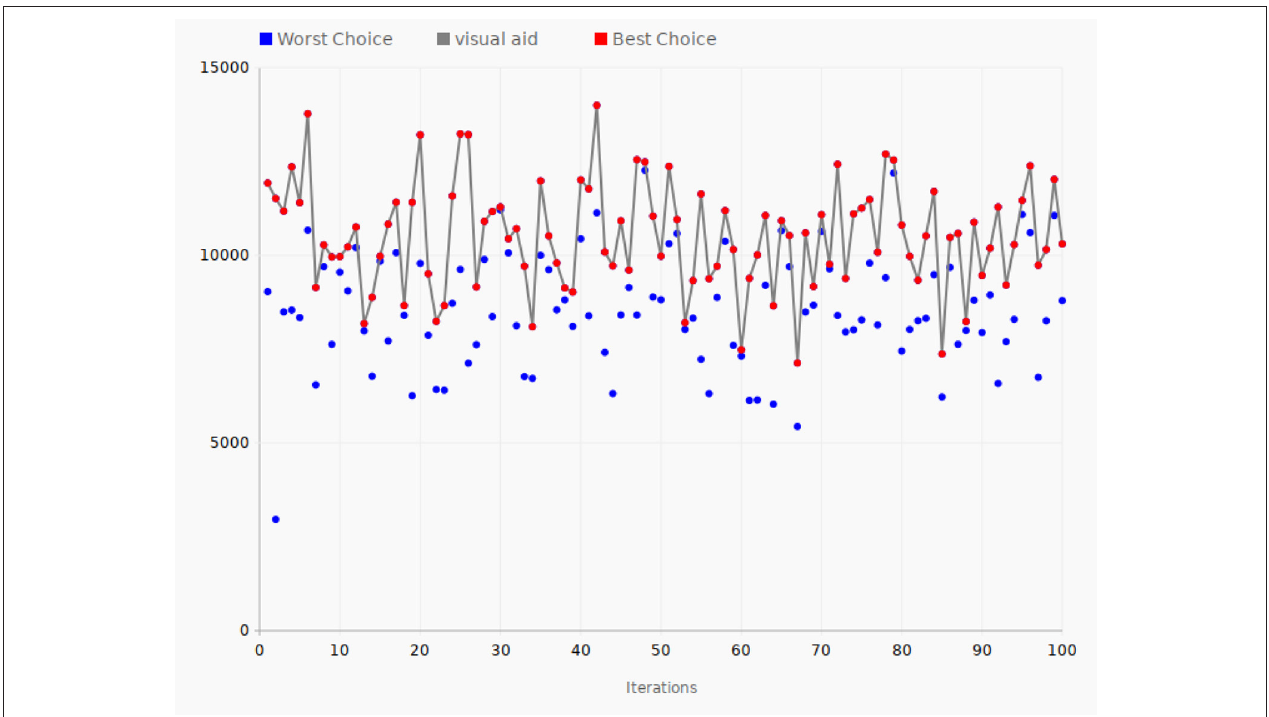
FIGURE 8 | Tuning process—HTTP logs data. The gray line connects the best choices that give the largest value of the objective function for each of the 100